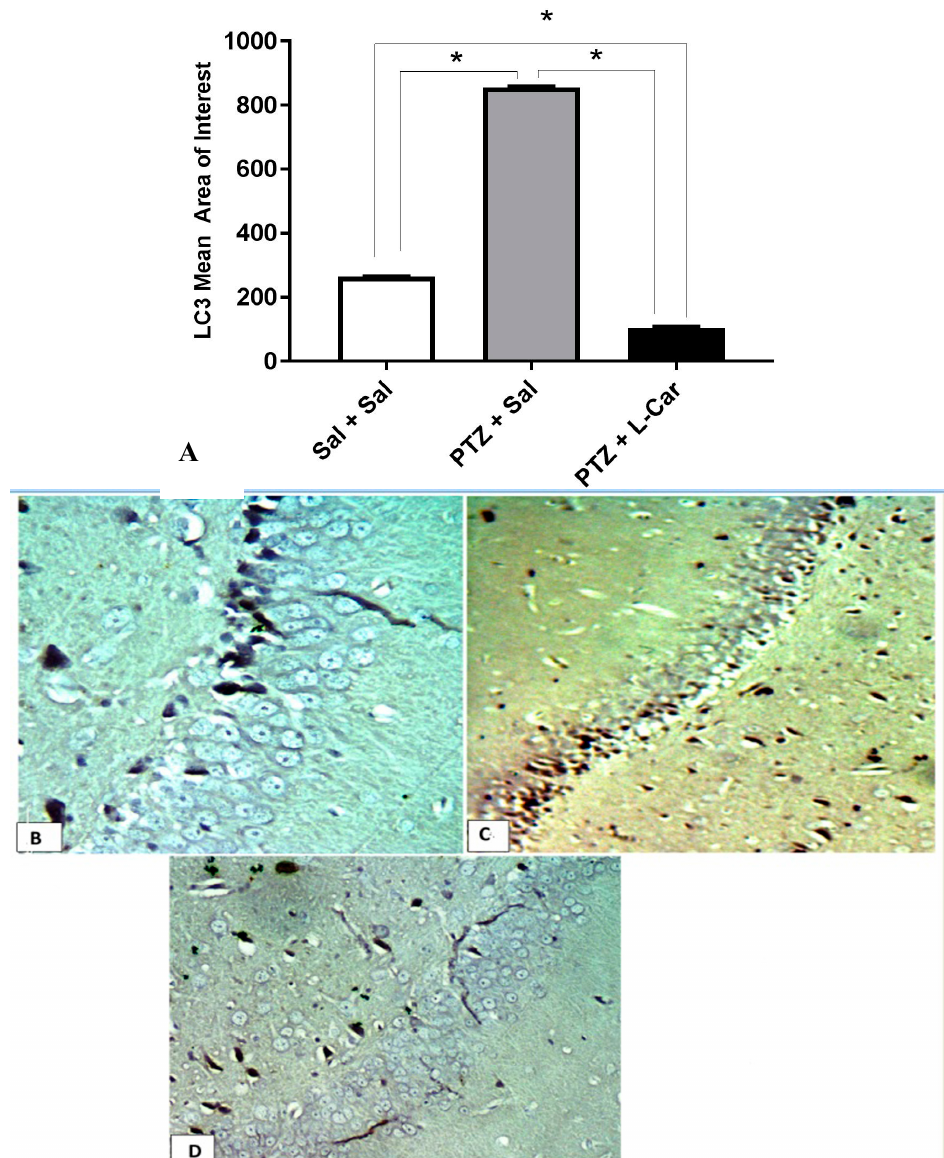
Figure 5. Mean area of interest of LC3 positivity in the CA3 region of hippocampus from different groups ( A ). LC mean area of interest by one-way ANOVA F(2,15) = 72,703, p < 0.0001. Tukey multiple comparisons test was done between the groups. There was a significant difference between PTZ + Sal vs. PTZ + L -Car (*) mean difference = 750.8. 95% CI of difference = 745.5 to 756.2, p < 0.0001 and also between Sal + Sal vs. PTZ + L -Car (*) mean difference = 160.4. 95% CI of difference = 155 to 165.8, p < 0.0001, and also between PTZ + Sal vs. Sal + Sal (mean difference = 590.4 95% CI of difference = 585 to 595.8, p < 0.0001). Section of brain in the CA3 region of hippocampus showing negative expression for LC3 in the Sal group ( B , 400×), high cytoplasmic expression in the Sal + PTZ group ( C , 400×) and low expression for LC3 in the L -Car + PTZ group ( D , 400×).